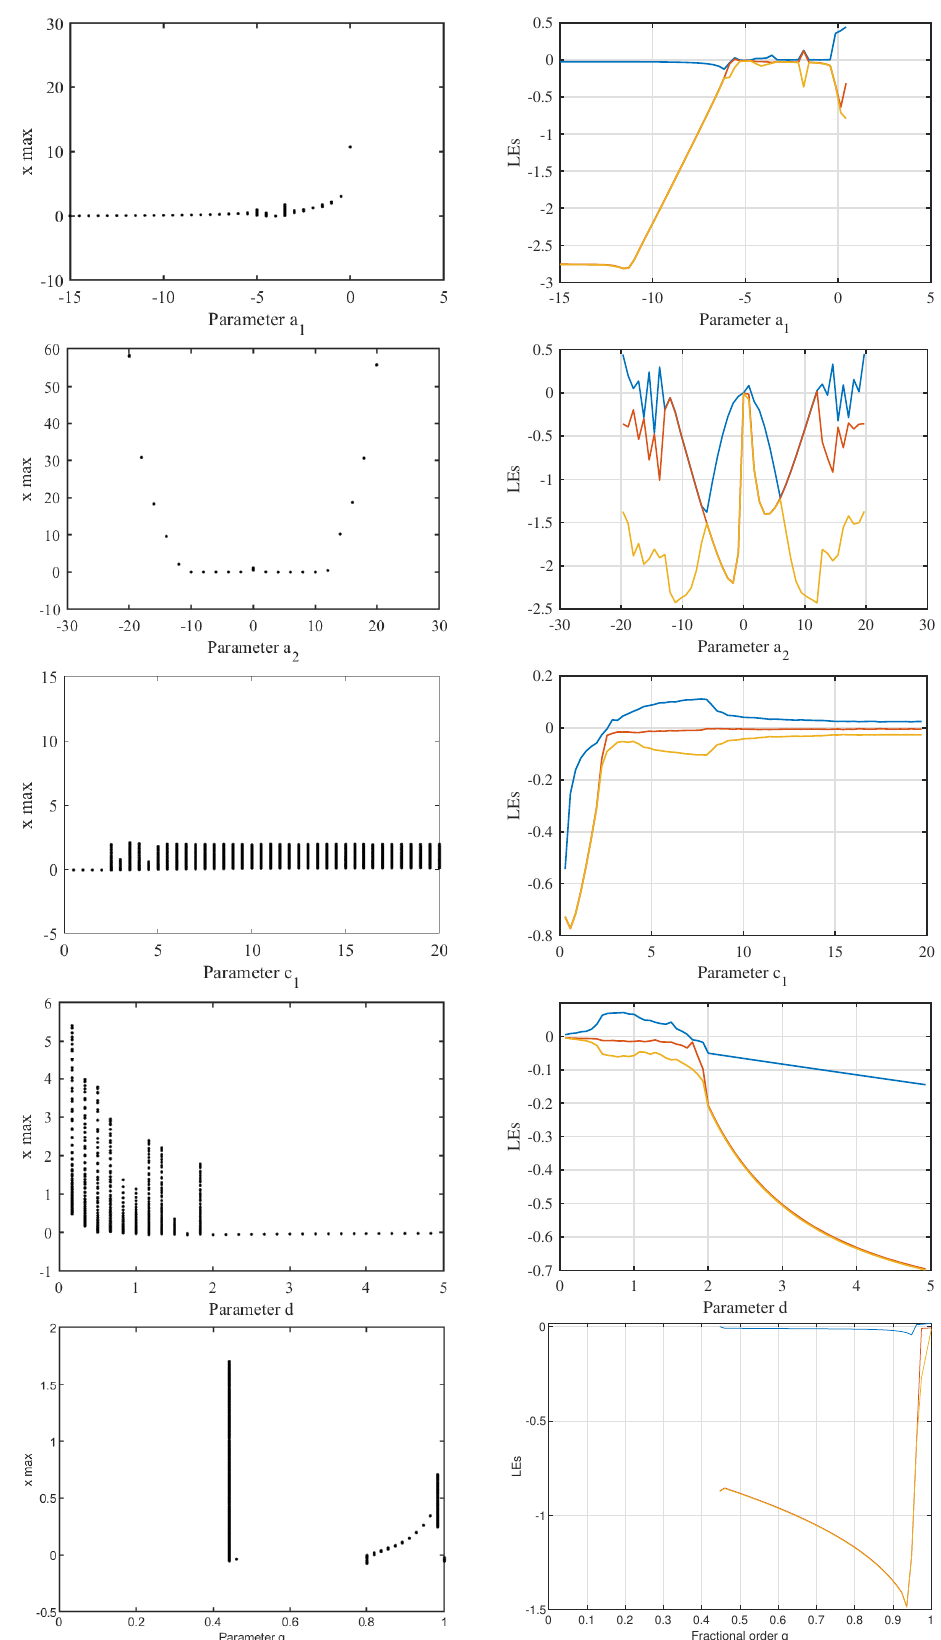
Figure 5. Bifurcation diagrams and Lyapunov exponents spectra of the optimized fractional-order system (2), using parameters a 1 , a 2 , c 1 , d and fractional-order q , for the non-optimized